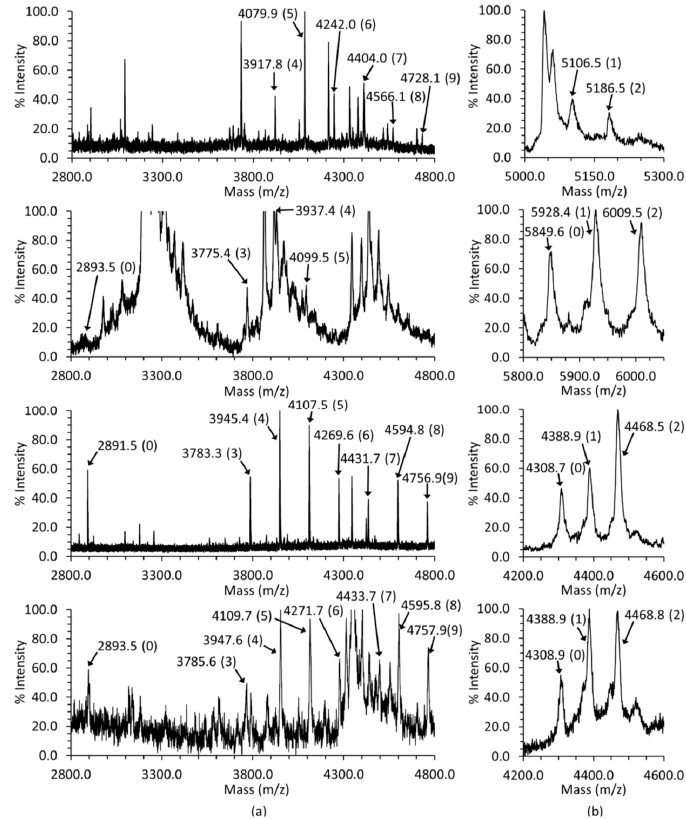
Figure 2. The mass spectra of bovine ( top row), rat ( middle row) and the two human Casq2s ( bottom two rows). ( a ) Casq2 glycosylation spectra. The mass of each peak corresponding to either the non-glycosylated peptide or a glycopeptide is labeled, with each mannose contributing an extra 162 m / z . The parenthetical number, ( n ), associated with each mass indicates the number of mannose present, except the case of the non-glycosylated peptide, which does not have any sugars attached. The GlcNAc 2 is implied, i.e., ( n ) denotes GlcNAc 2 Man ( n ) ; ( b ) the C-terminal peptide masses with their corresponding number of phosphoryls are indicated in parentheses. A difference of 80 m / z indicates an additional phosphoryl group (as HPO 3 ). The spectra for the peptides were collected using a 4800